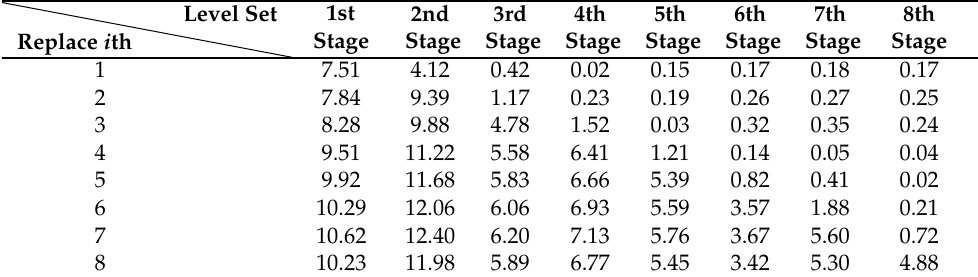
Table 4. Pressure error of replacing all levels under total variable